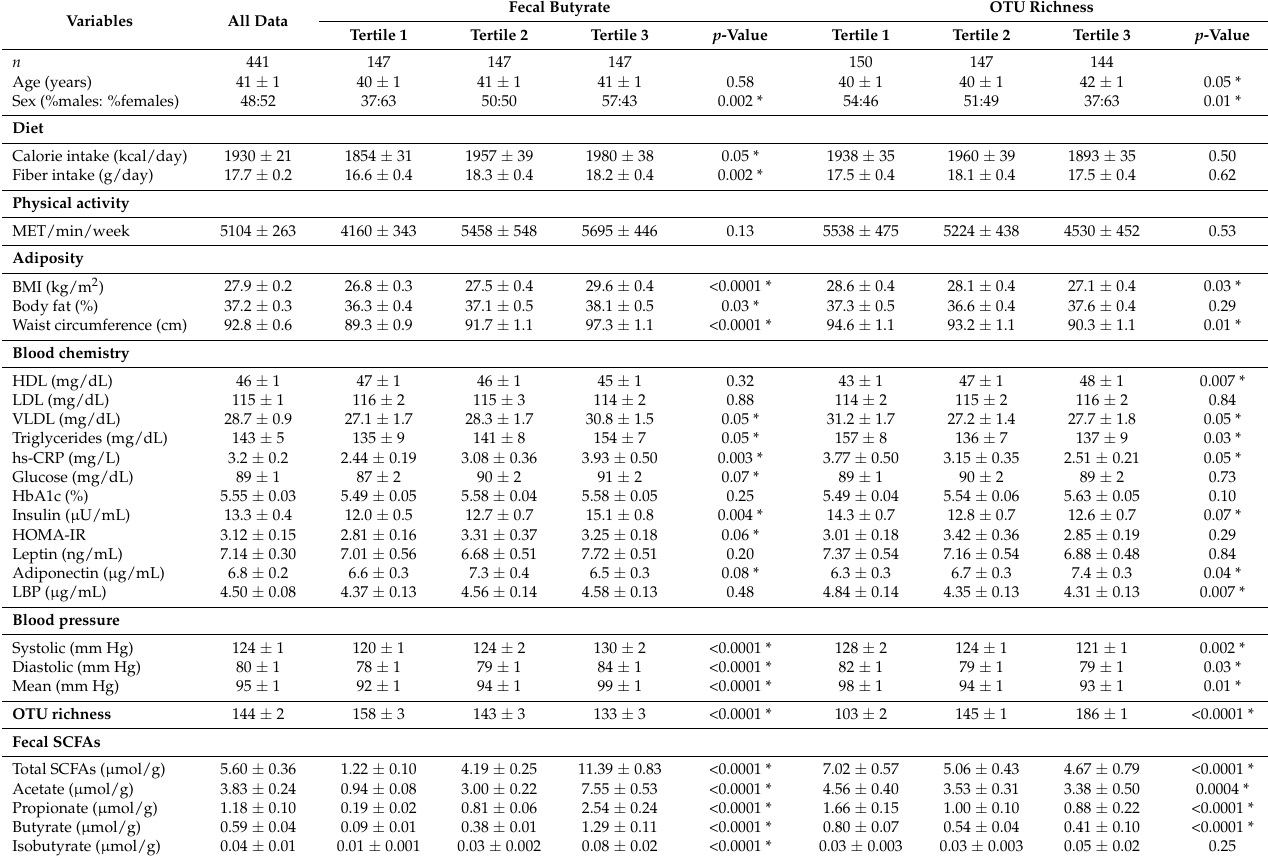
Table 1. Characteristics of the study